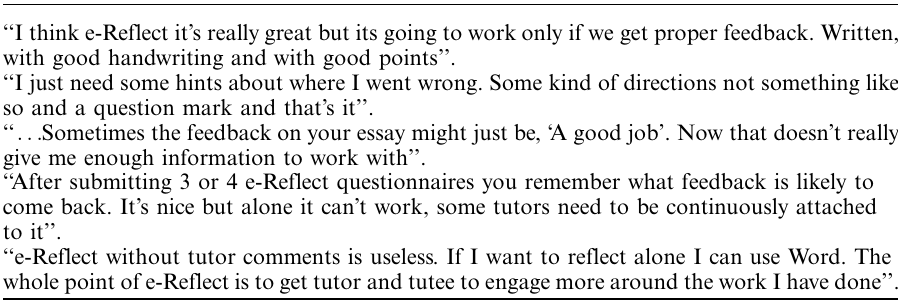
Table 2. Student comments on the MAC process in relation to quality and feedback.